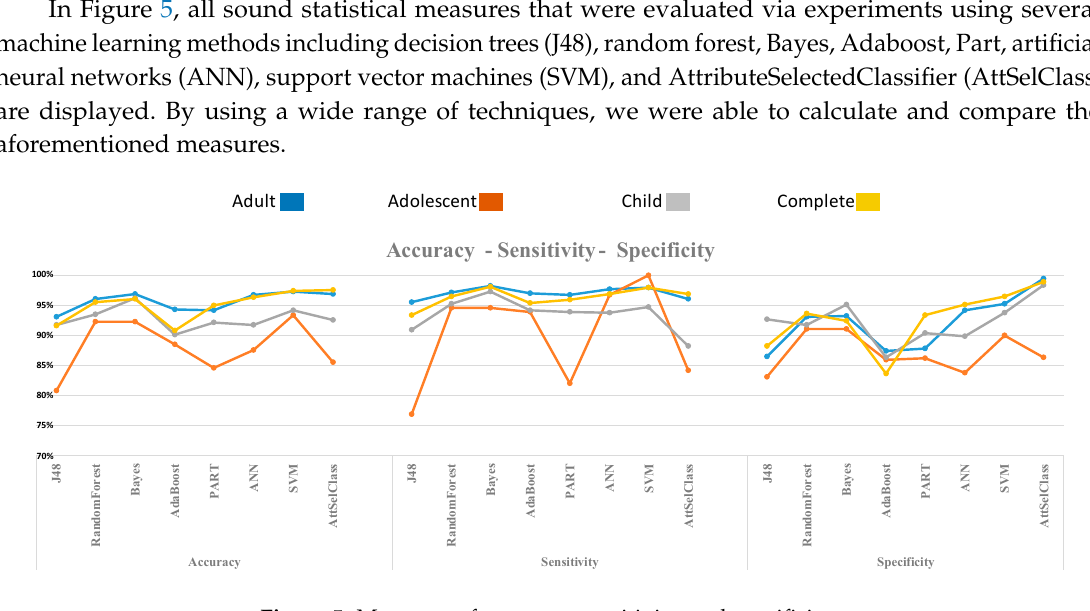
Figure 5. Measures of accuracy, sensitivity, and specificity.